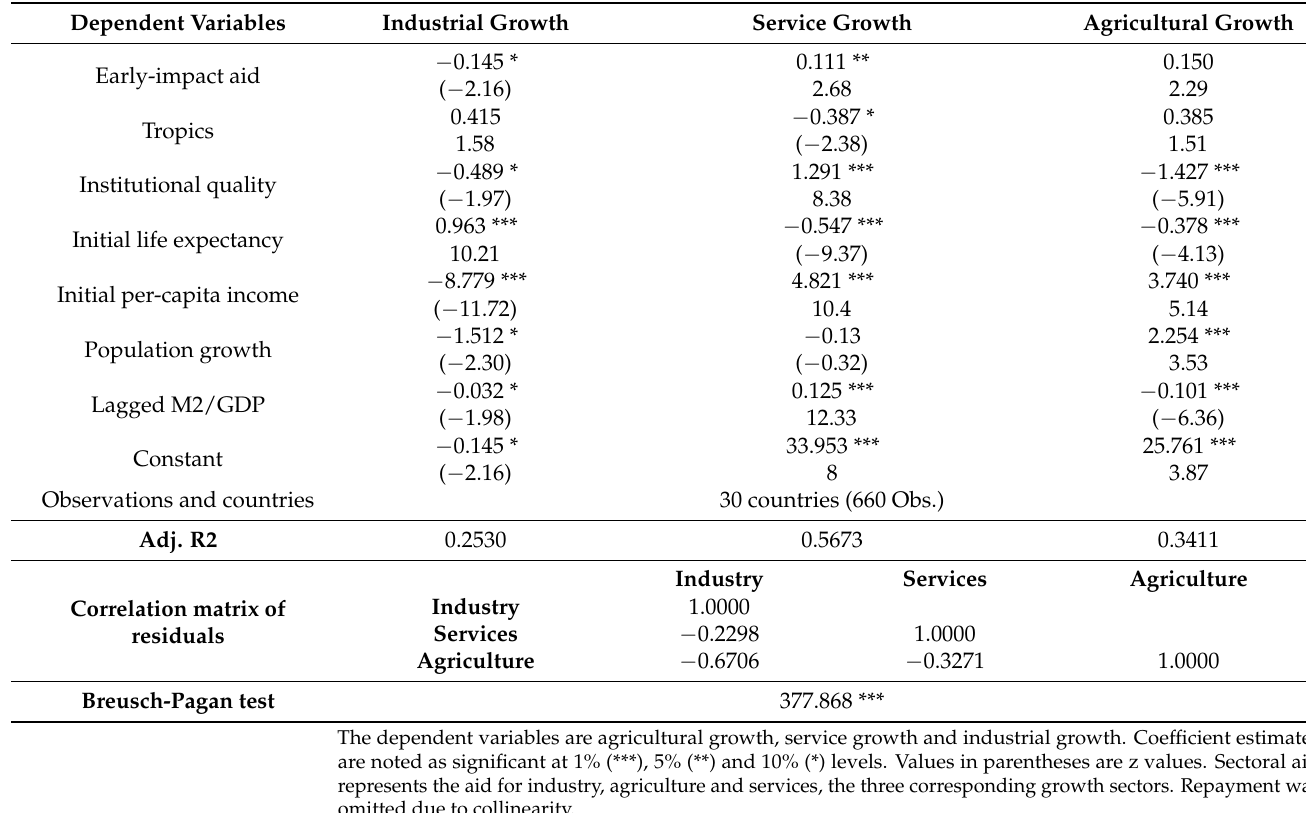
Table 4. Empirical estimations of early-impact aid